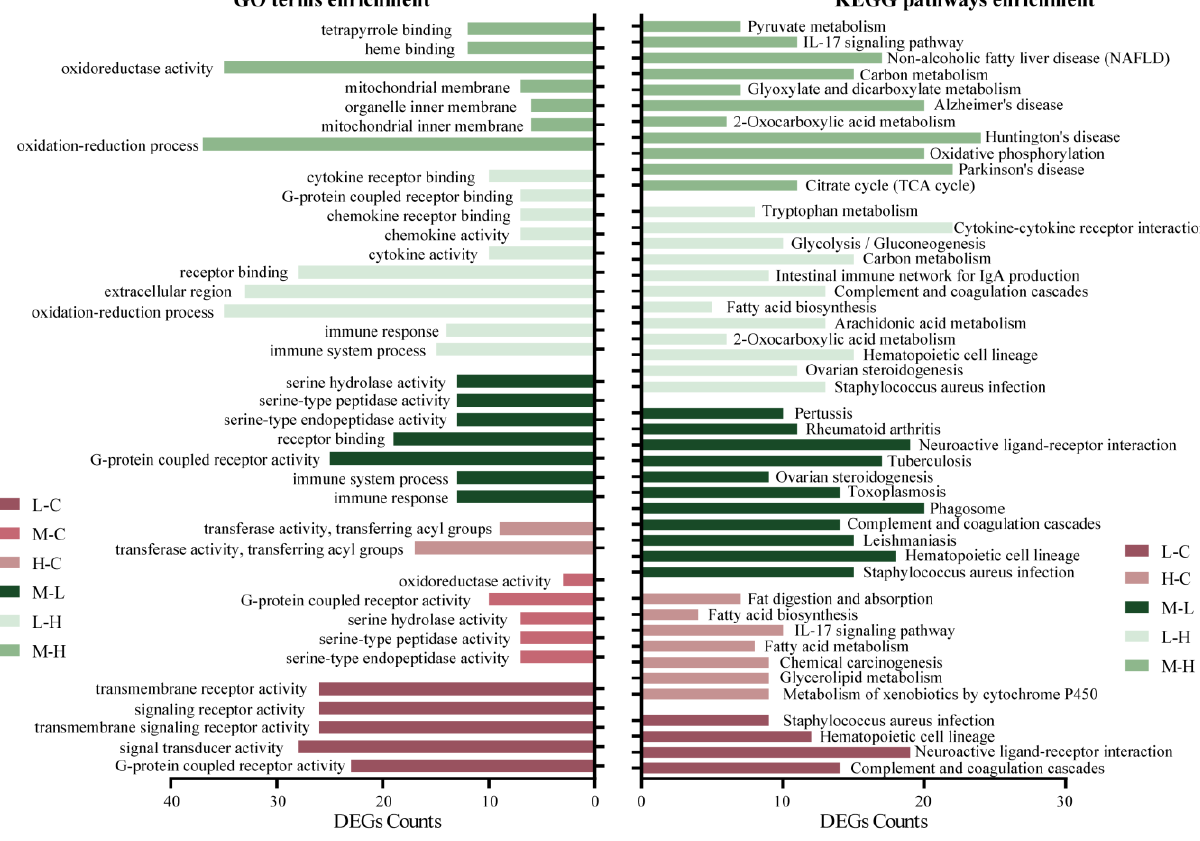
Figure 3. The significantly enriched Gene Ontology (GO) terms and Kyoto Encyclopedia of Genes and Genomes (KEGG) pathways for differentially expressed genes (DEGs) in the different groups of Agriophyllum squarrosum supplemented Tan lambs. C, control; L, 10% A. squarrosum diet; M, 20% A. squarrosum diet; H, 30% A. squarrosum diet.